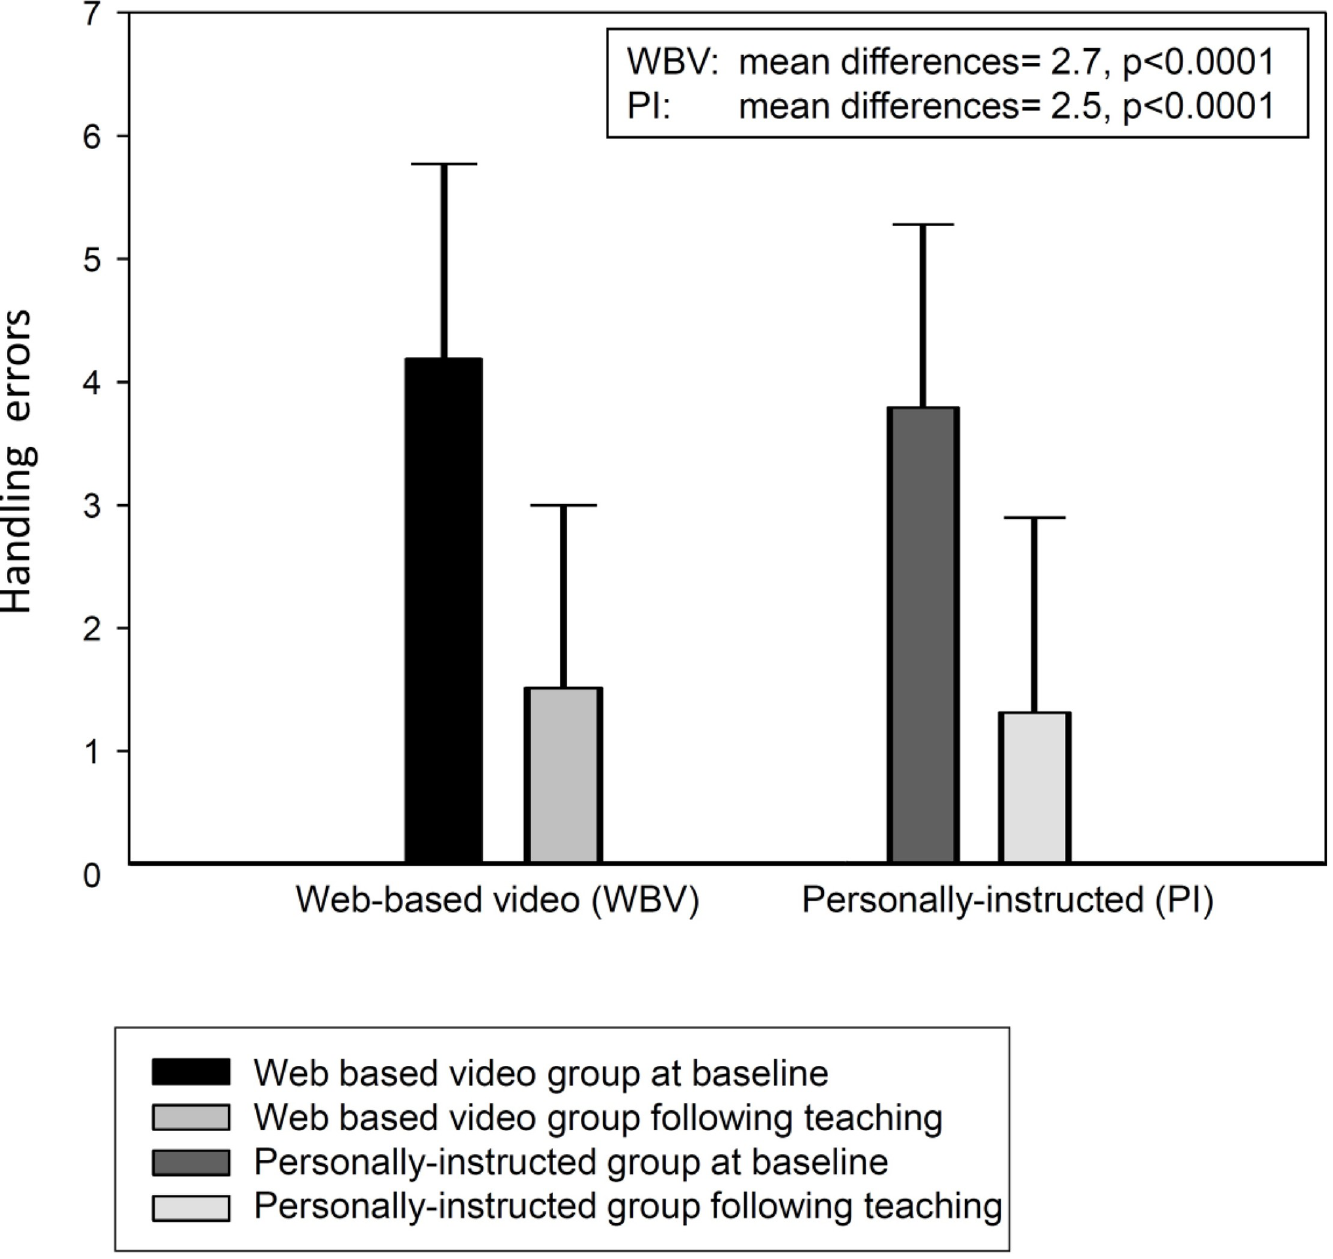
Fig 2. Inhalation error rate at baseline and following teaching (N =